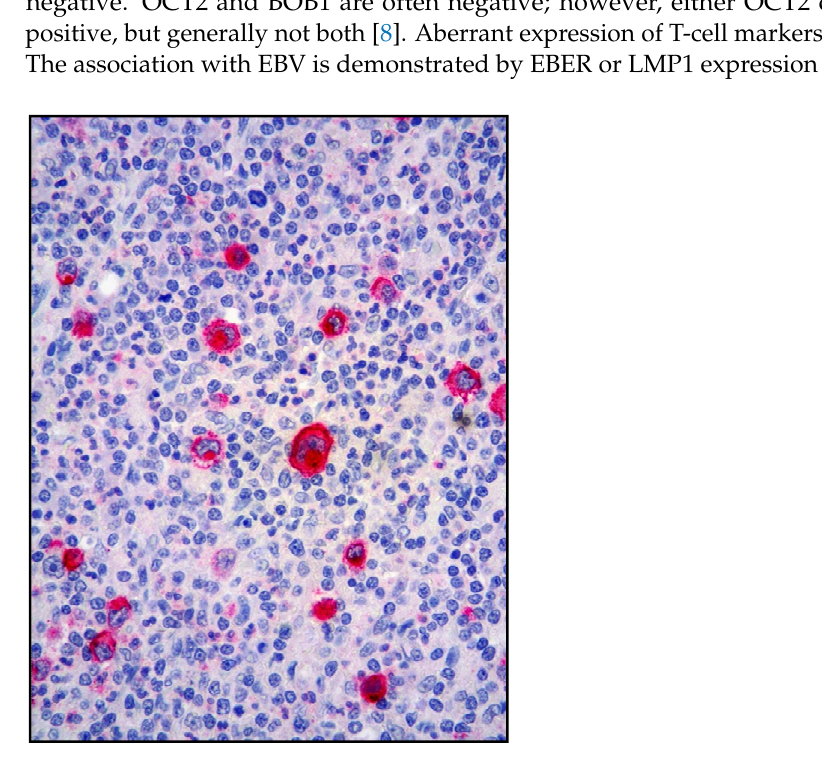
Figure 5. cHL: LMP1 expression in Hodgkin cells (immunostaining, magnification 400×; original image from Prof S.A.).